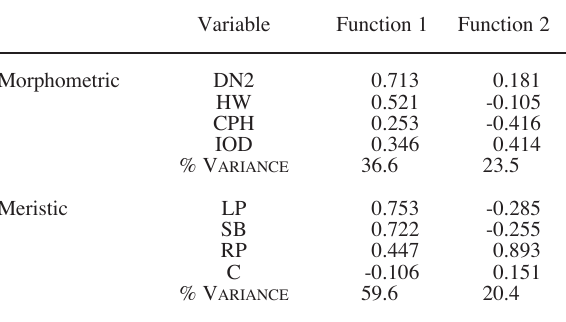
Table 1 for variables’